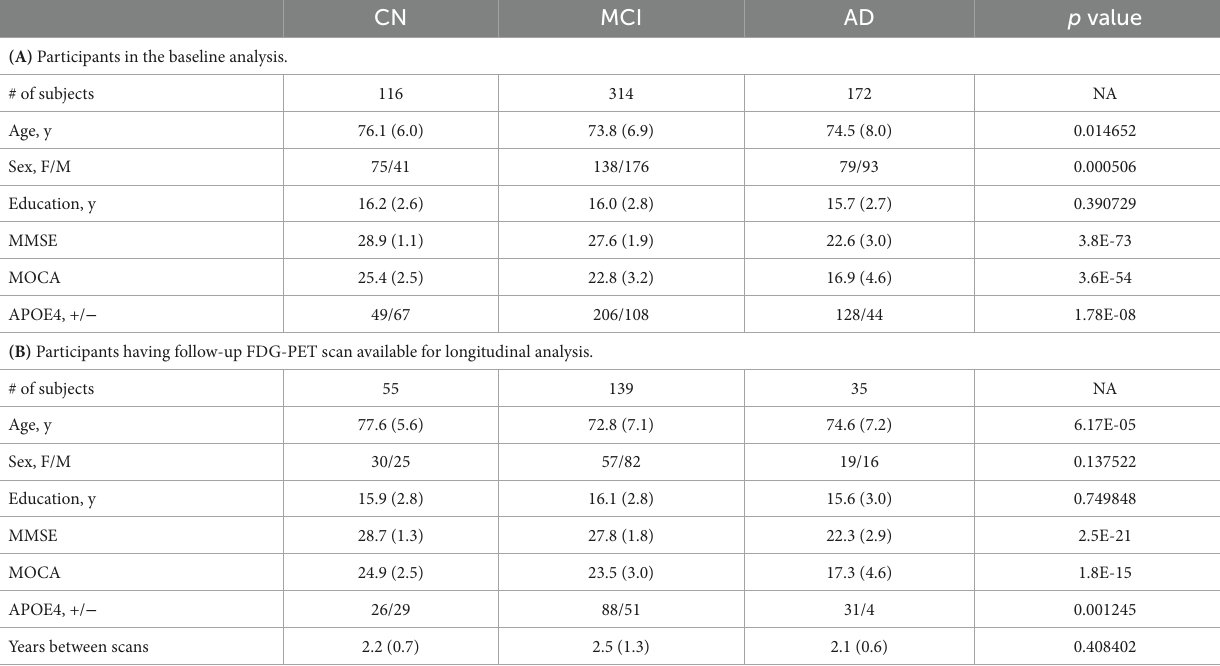
TABLE 1 Demographic